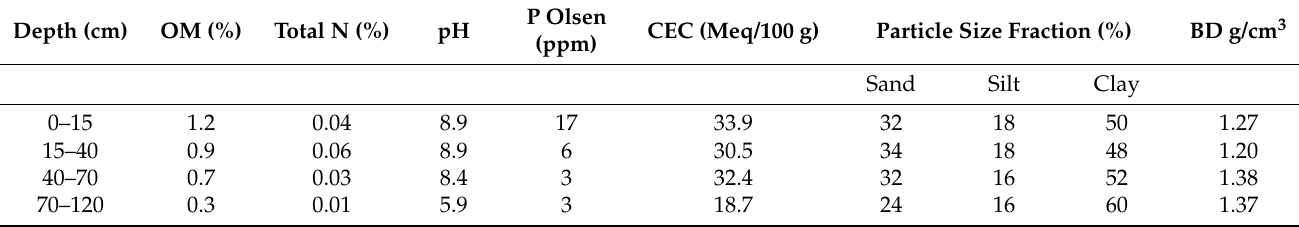
Table 8. Chemical and physical properties for the soil profile at Ciudad Obregon, Mexico [28,29]. Depth